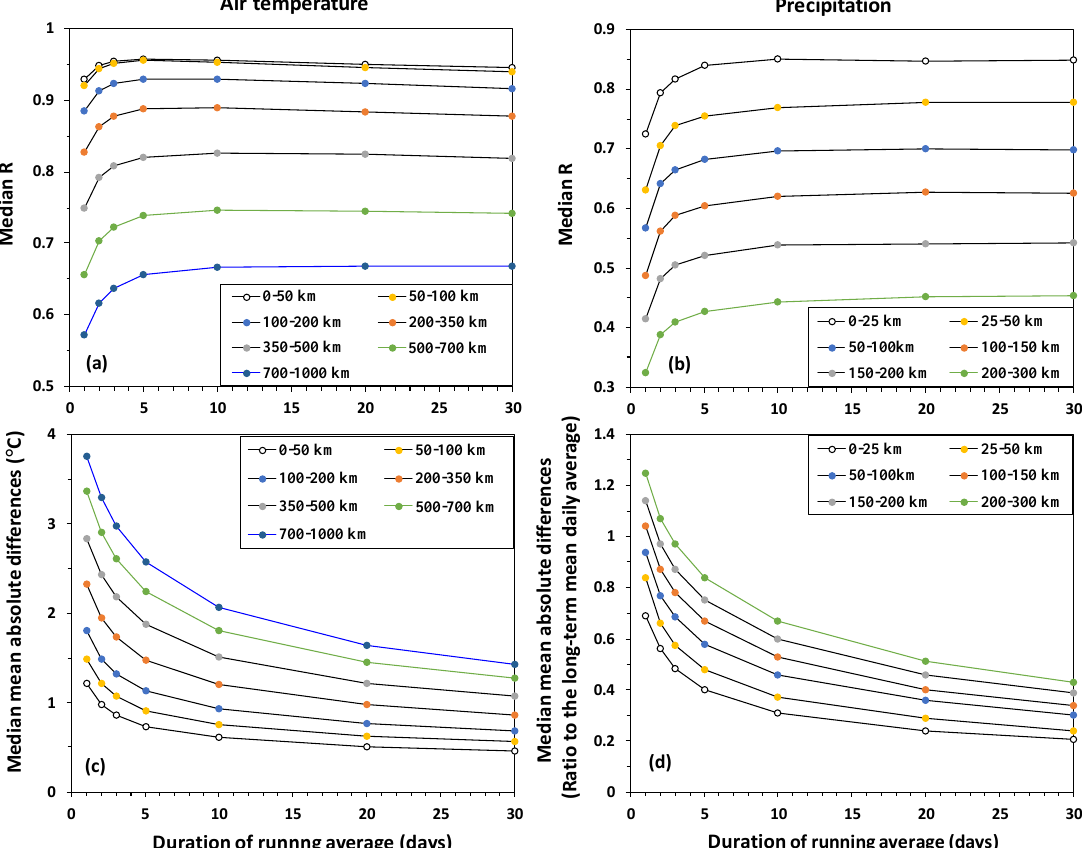
Figure 4. Changes of correlation coe ffi cients (R) ( a , b ) and mean absolute di ff erences ( c , d ) between climate stations with duration of running average for air temperature ( a , c ) and precipitation ( b , d ). They were calculated using the deviations (di ff erences for air temperature and ratios for precipitation) from the long-term daily averages, which were interpolated from the long-term monthly averages. Each curve represents the median values calculated from all the stations within a certain distance range.